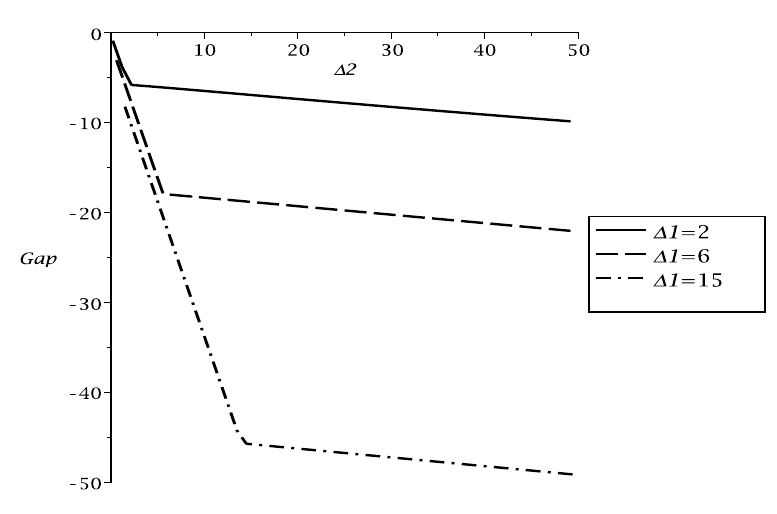
= 0.6, q = 6, p = 6 and q = 1 1 2 2